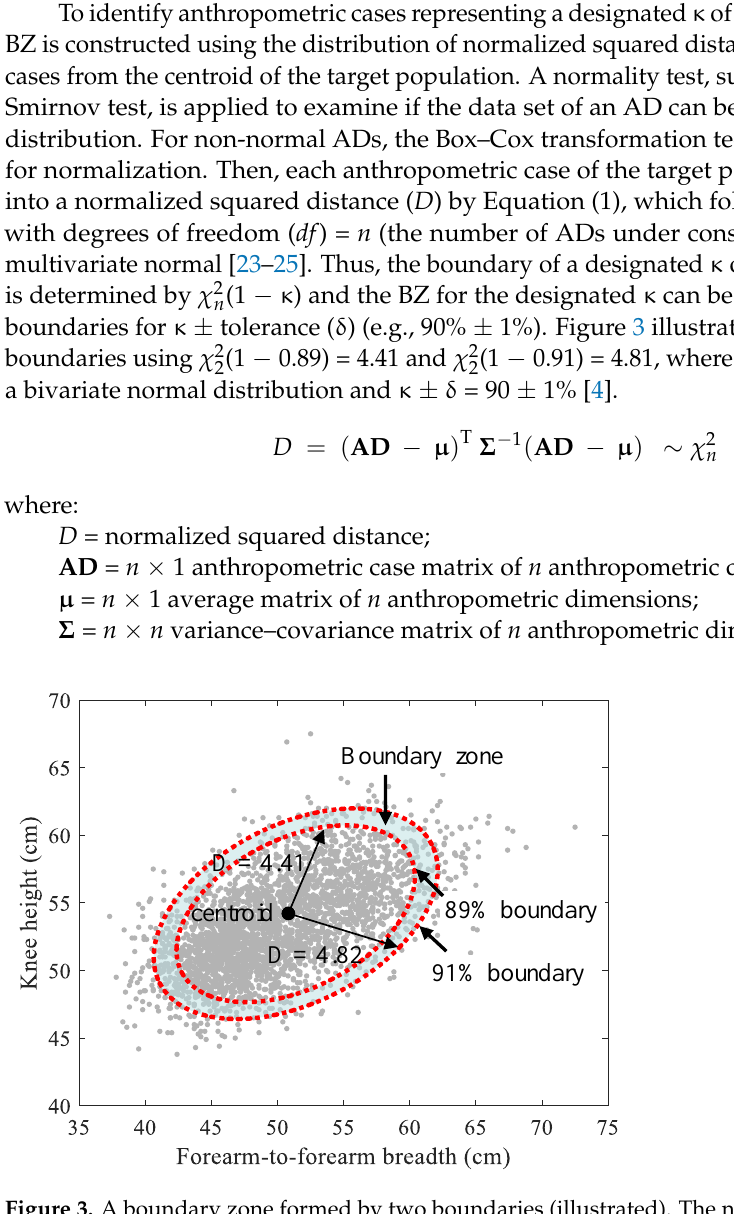
Figure 3. A boundary zone formed by two boundaries (illustrated). The number of anthropometric dimensions ( n ) = 2; accommodation percentage (κ) = 90%; tolerance (δ) = 1%.